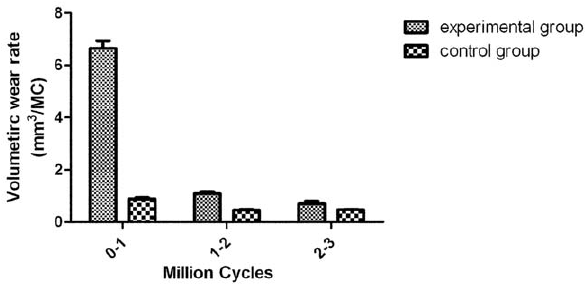
Figure 6. The ion levels(Levels of Co, Cr) in lubricant from 0.33, 0.66, 1.0, 1.5, 2.0. 2.5 and 3.0 MC test-points. Mean values displayed in parts per billion (ppb).